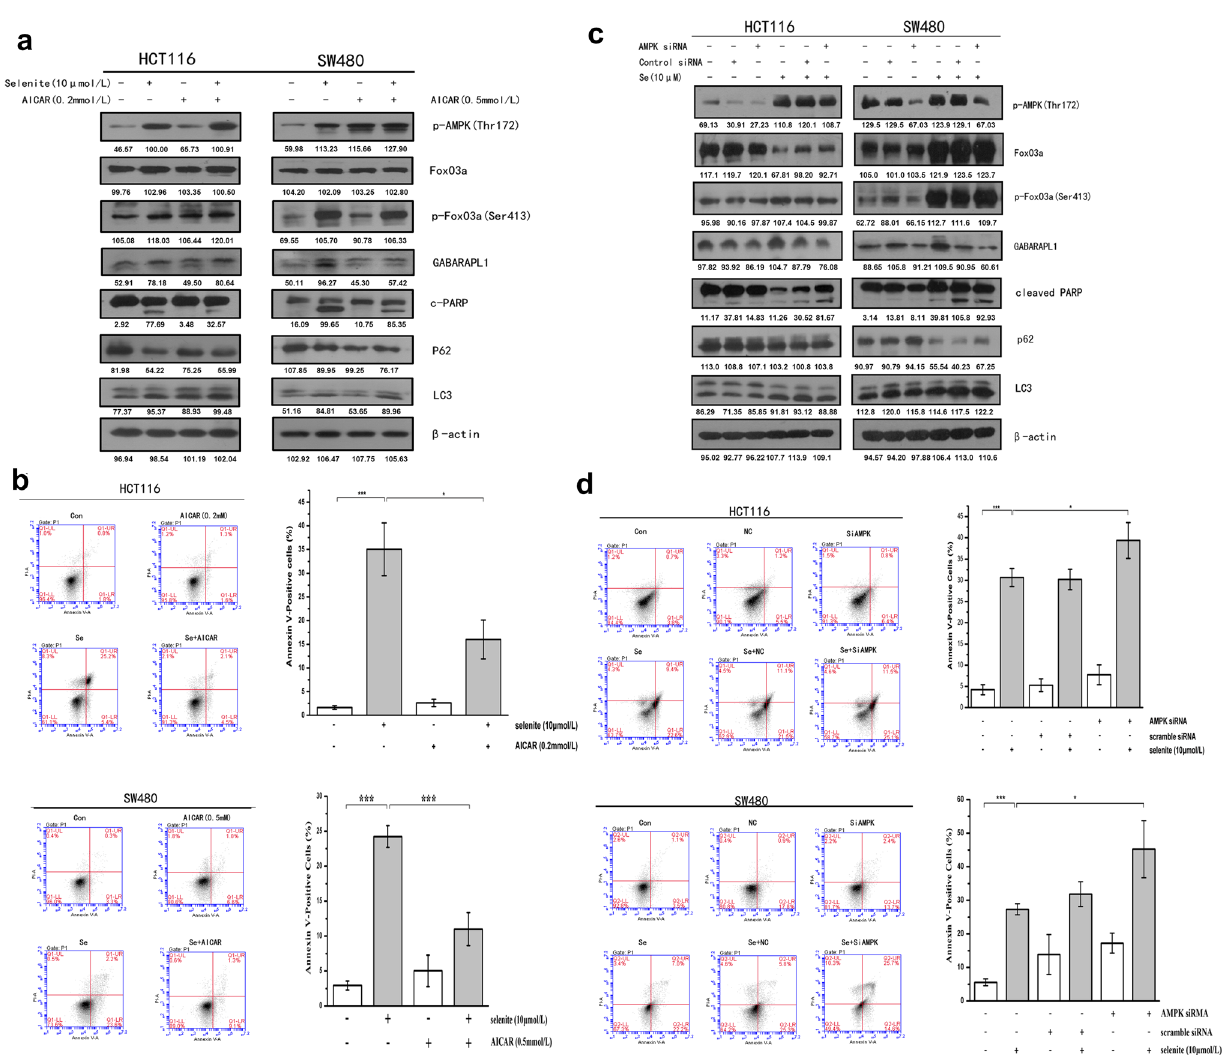
Fig. 3 Selenite-induced AMPK-dependent autophagy protected cells against apoptosis. a and b Activating AMPK enhanced selenite- induced autophagy and attenuated apoptosis. 0.2 mM AMPK activator AICAR was added to HCT116 cells and 0.5 mM AICAR was added to SW480 cells 2 h prior to 10 µM selenite treatment. Samples were collected and subjected to western blot analysis incubated with indicated antibodies or FACS analysis. c and d Silencing AMPK reduced selenite-induced autophagy and promoted apoptosis. HCT116 and SW480 cells were transfected with siRNA targeting AMPK before selenite treatment and subjected to western blot or FACS analysis. The statistical graphs are presented as the mean ± S.D. of the three independent experiments, * p <